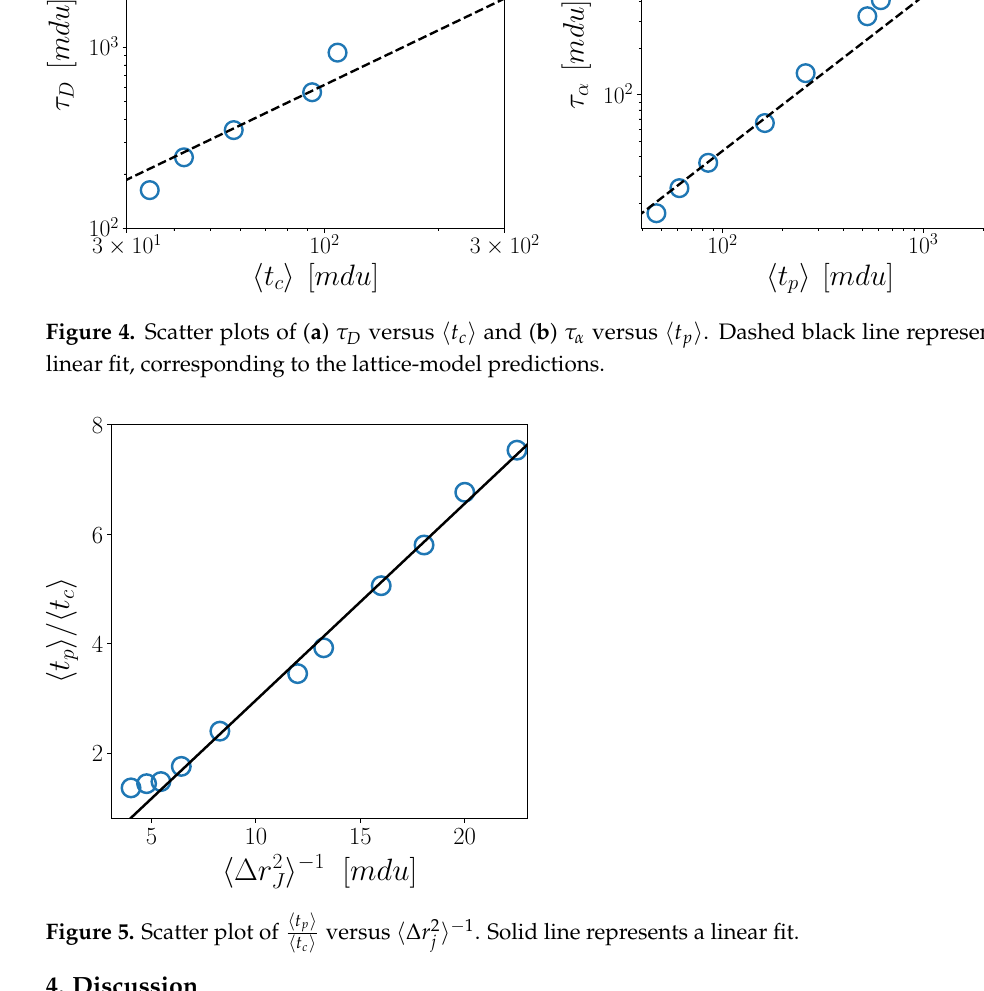
Figure 5. Scatter plot of (cid:104) t p (cid:105)